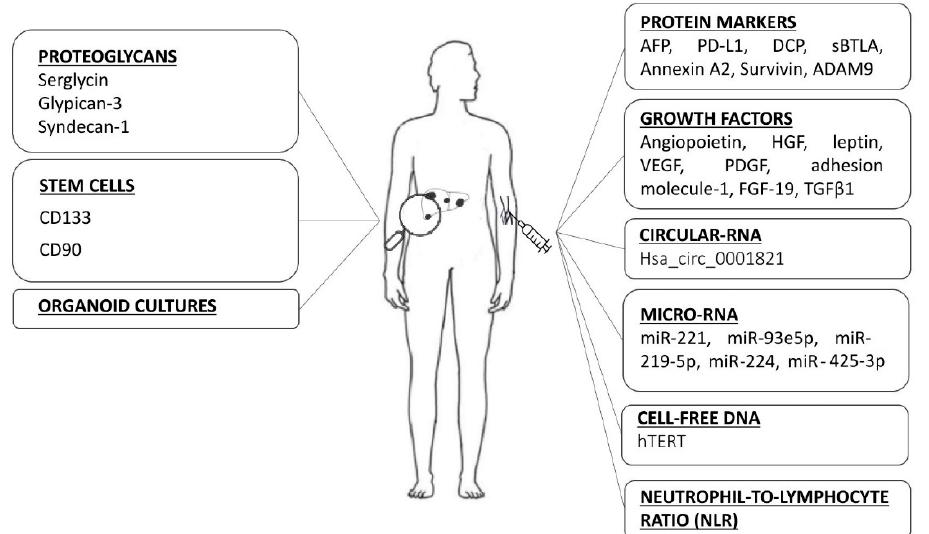
Figure 1. Many heterogeneous categories of biomarkers are being investigated as possible prognostic parameters in predicting the therapeutic efficacy and survival in advanced HCC. AFP: alpha-fetoprotein, PD-L1: programmed cell death-1 ligand, DCP: des- γ -carboxy prothrombin, sBTLA: soluble B and T lymphocyte attenuator, ADAM9: a-disintegrin-and-a-metalloprotease-9, HGF: hepatocyte growth factor, VEGF: vascular endothelial growth factor, PDGF: platelet-derived growth factor, FGF-19: fibroblast growth factor 19, TGF- β 1: transforming growth factor beta 1, miR: microRNA, hTERT: human telomerase reverse transcriptase.